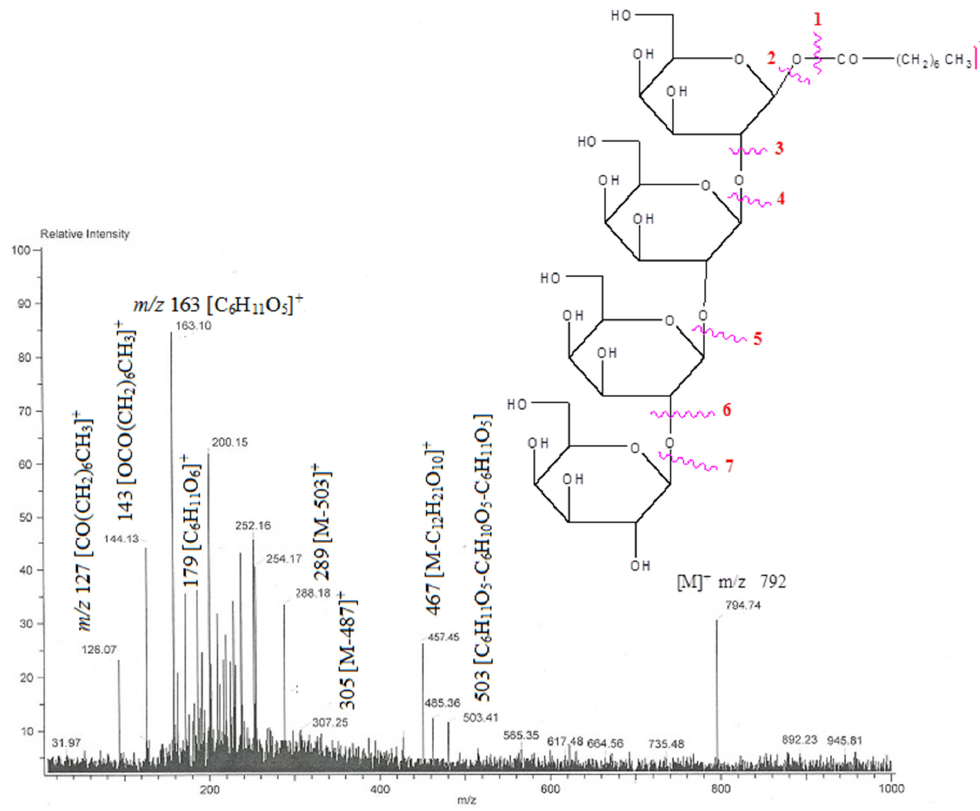
Figure 10. The diagnostic MS/MS fragmentation at m/z 792 full ESI-MS scan of the isolated compound AB-05.